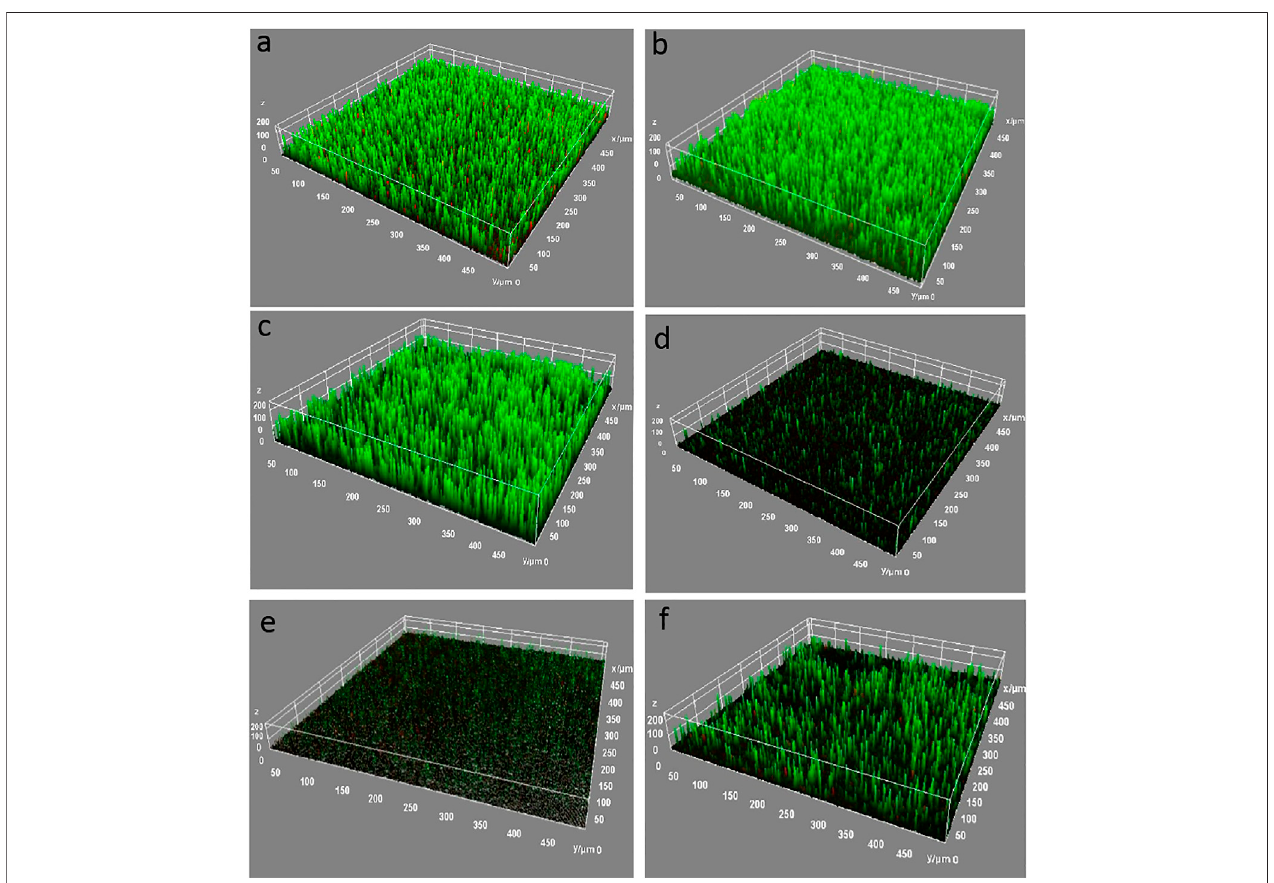
FIGURE 4 | CLSM images of bio fi lm growth for 72 h on different coating surfaces. (A) bare steel; (B) WEP coating (control); (C) GOWE-0.05 (0.05 wt% GO); (D) GOWE-0.1 (0.1 wt% GO); (E) GOWE-0.5 (0.5 wt% GO); (F) GOWE-1(1 wt% GO). The green color corresponds to living bacterial cells growing on the surface. Experiments were run at 25 ° C under static batch condition. The units are in